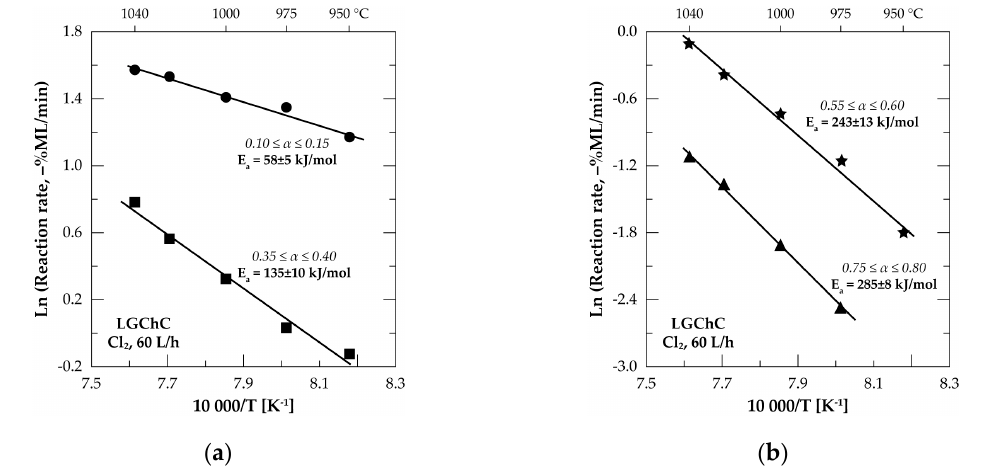
Figure 9. Examples of the Arrhenius diagrams for the reaction of LGChC with Cl 2 : ( a ) 0.10 ≤ α ≤ 0.15 and 0.35 ≤ α ≤ 0.40; ( b ) 0.55 ≤ α ≤ 0.60 and 0.75 ≤ α ≤ 0.80.